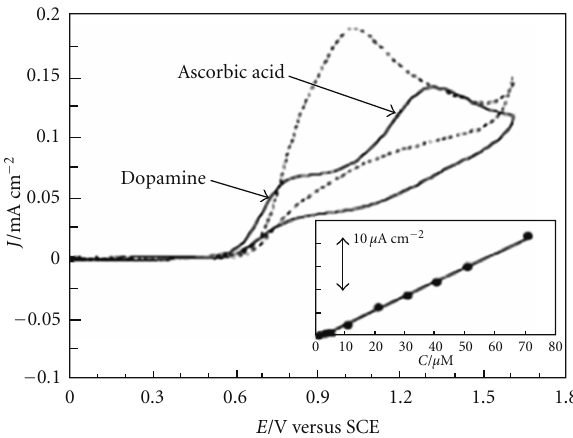
Figure 7: Cyclic voltammogram for a 0.1 M HClO 4 solution containing 0.1mM DA and 1 mM AA at as-deposited and oxidized BDD electrodes. The scan rate was 100 mVs − 1 . Inset shows a cyclic voltammogram calibration curve for DA in 0.1 M HClO 4 solution in the presence of 1mM